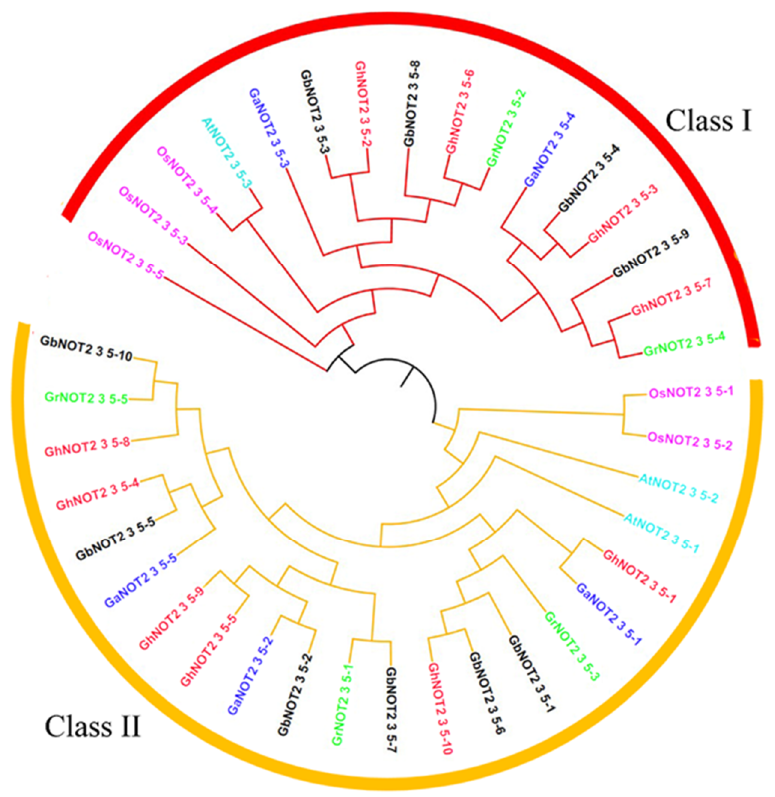
Figure 1. Phylogenetic analysis of NOT2_3_5 genes from cotton and other plants. Prefixes At, Os, Gr, Ga, Gh and Gb represented Arabidopsis thaliana , Oryza sativa , G. raimondii , G. arboretum , G. hirsutum and G. barbadense , respectively. NOT 2_3_5 domain protein from G. hirsutum , G. barbadense , G. raimondii , G. arboretum , Arabidopsis thaliana and Oryza sativa were marked red, black, green, blue, turquoise and pink, respectively.